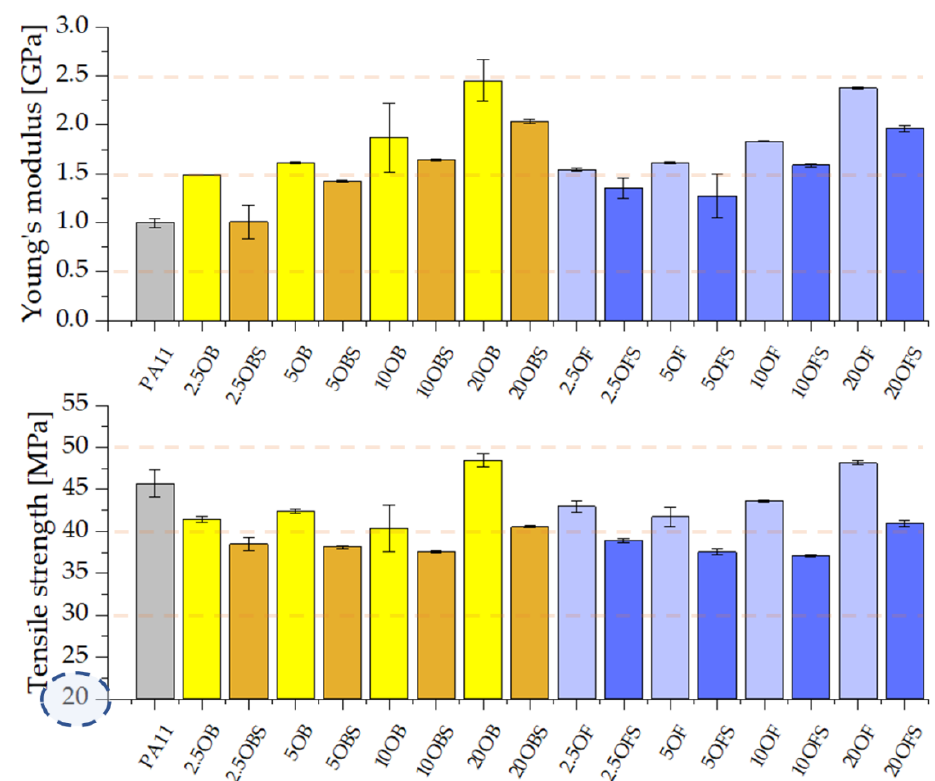
Figure 8. Young’s modulus and tensile strength of PA11 composites containing silanized and non- silanized diatomite.